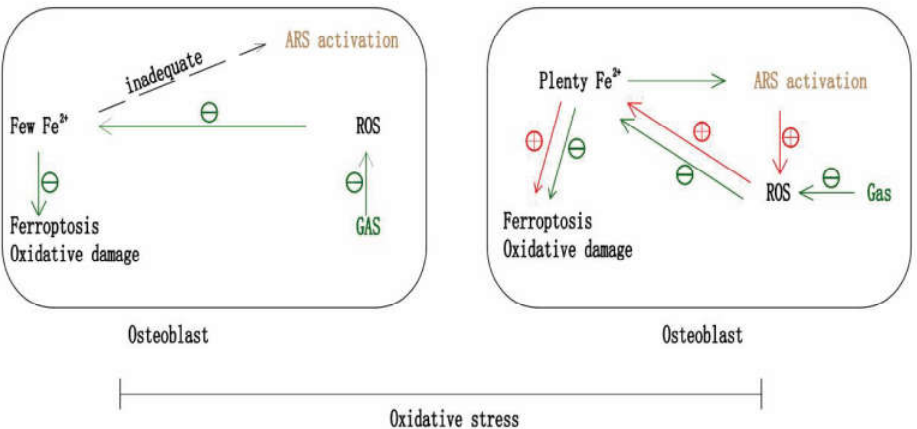
Figure 5. The potential combination of gastrodin and artemisinin for anti-osteoporosis. Gastrodin protects osteoblast and osteoclast from oxidative damage and ferroptosis under oxidative stress. Due to higher intracellular iron content, ARS selectively inhibits osteoclast activity. Therefore, the combination of gastrodin and ARS may have greater therapeutic potential for